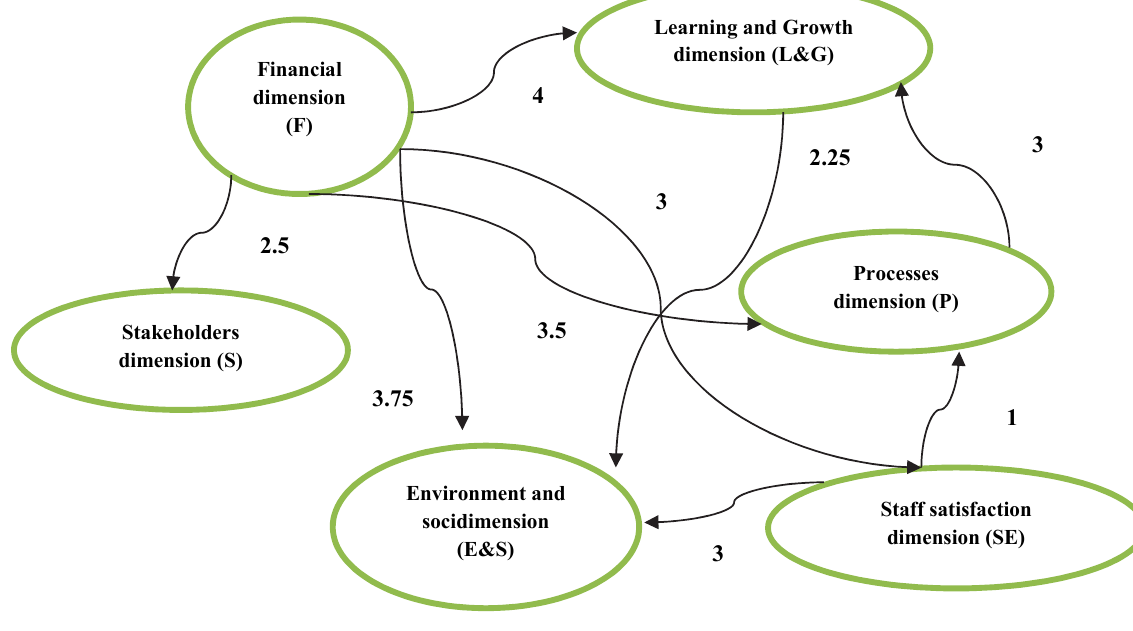
Fig. 4. Diagraph of KM evaluation dimensions resulted from